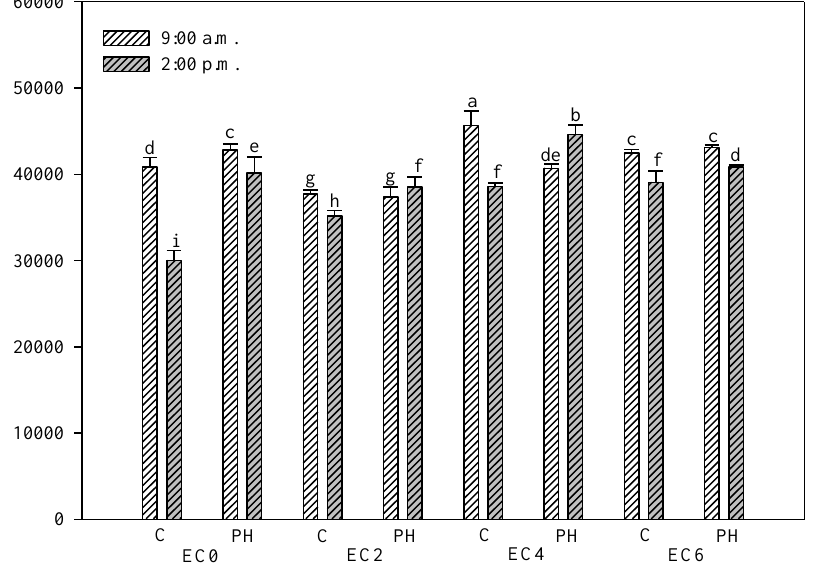
Figure 4. Fm (maximum fluorescence) of hemp leaves in the DAS as affected by saline water irrigation (EC0 = non-saline water; EC2 = water at 2.0 dS m − 1 ; EC4 = water at 4.0 dS m − 1 ; EC6 = water at 6.0 dS m − 1 ) and biostimulant application (treated with a commercial legume-derived protein hydrolysate = PH and non-treated = C) recorded at 9:00 a.m. and at 2:00 p.m. Bars are means ± s.e. ( n = 10). Bars with different letters are significantly different according to the Duncan’s test with p ≤ 0.05.